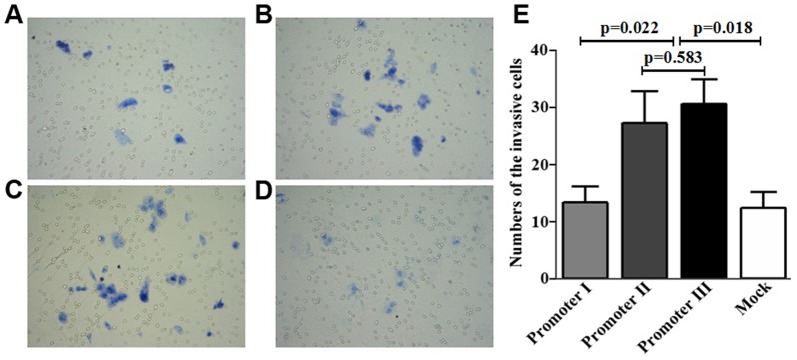
Effects of HTPAP promoter haplotype on HCC invasion in vitro.Transwell invasion assay showed that the migrated cell number of HepG2 cells transfected with HTPAP promoter II+III [promoter II (B), 28.4±5.5; promoter III (C),31.6±4.7] was significantly higher than that of the HepG2-HTPAP promoter I (A) (13.4±3.0) and HepG2-mock cells (D)(12.6±2.9) (p<0.05, respectively); no significant difference was found between HepG2 cells transfected with OPN-Ht3 and mock control (p = 0.583)(E).